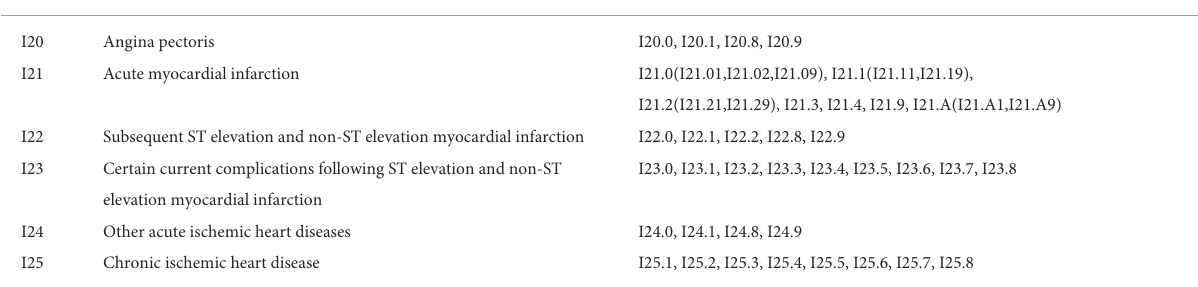
TABLE 1 ICD10 I20-I25 for